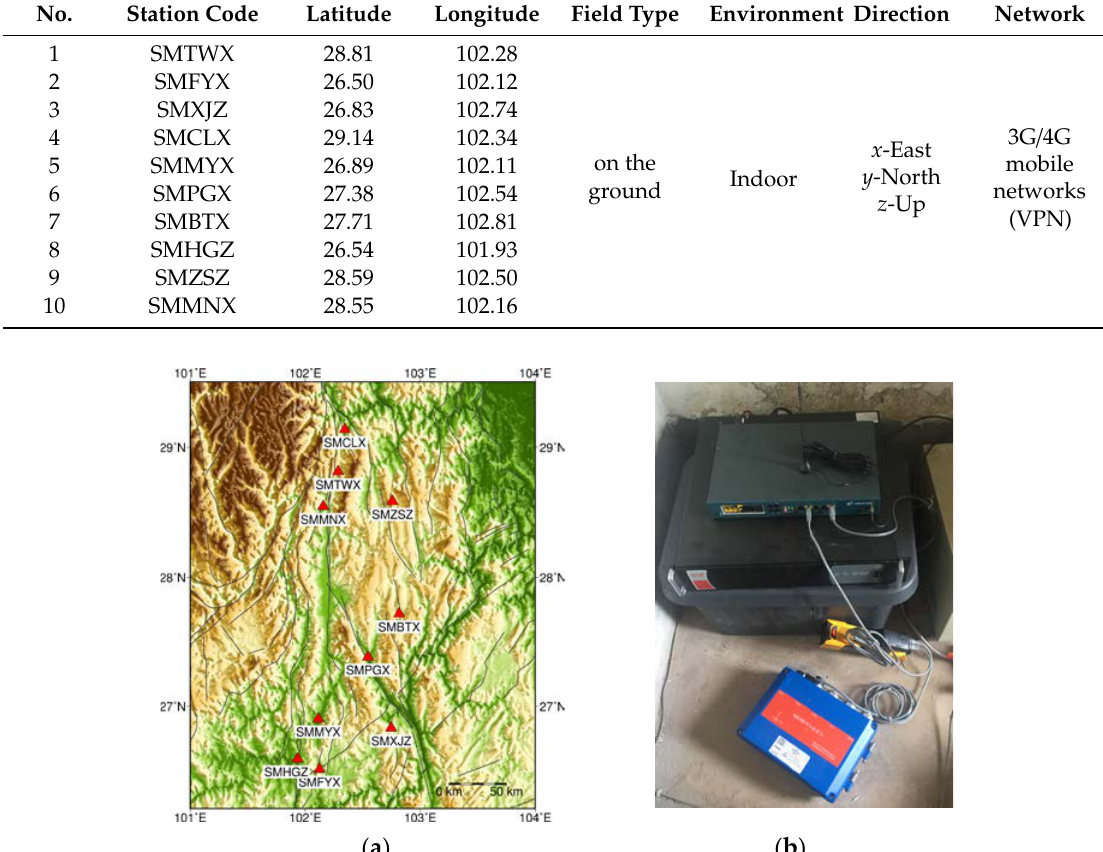
locations; ( b ) Depiction of the station equipment serving for the